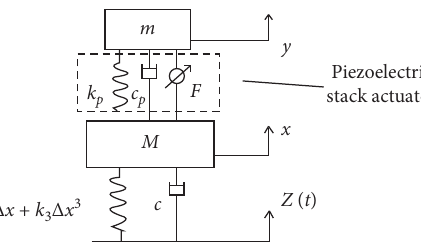
Figure 2: Mechanical model of the coupled